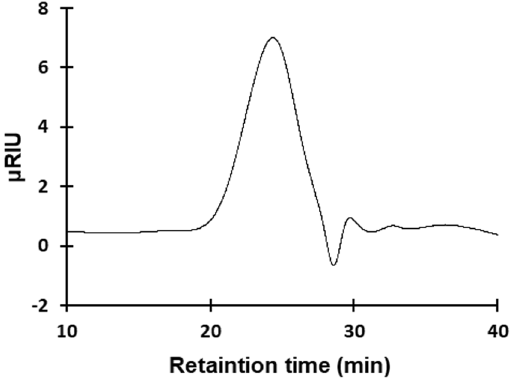
Figure 2. Chromatogram of the purified polysaccharide of B. mori pupae on size-exclusive gel filtration chromatography.